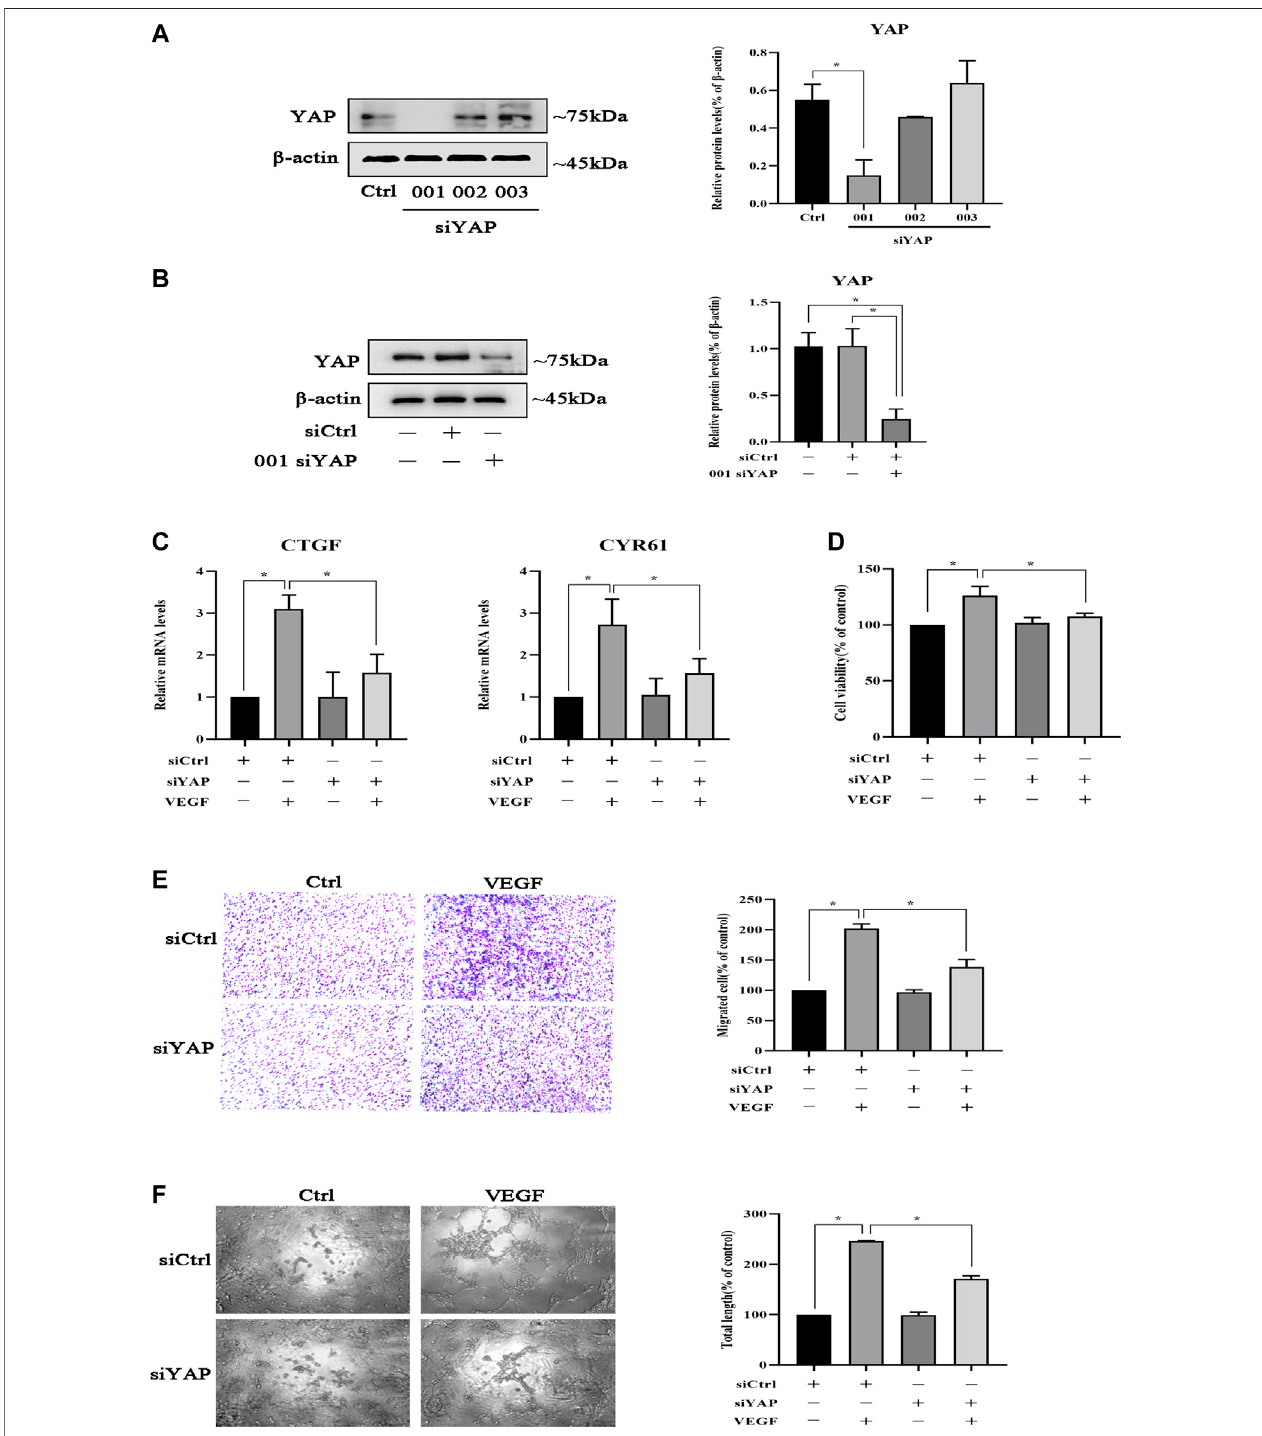
FIGURE5| YAPisinvolvedintheinhibitionofHPVECmigrationandtubeformation. (A) HPVECsweretransientlytransfectedwiththreekindsofSignalSilenceYAP siRNA for 48 h. Then YAP protein expressions were analyzed by western blotting. (B) HPVECs were transiently transfected with the SignalSilence YAP control siRNA (siCtrl) and 001 siRNA for 48 h. Western blotting was also used to detect YAP protein expression. (C – F) HPVECs were treated with siCtrl or YAP siRNA for 48 h and incubated with VEGF (50 ng/ml). (C) CTGF and CYR61 mRNA levels were analyzed by real-time PCR. (D) Cell proliferation was detected by CCK-8 assay. (E) MigrationofHPVECswasdetected bytranswellmigrationassay. (F) Tubeformationwasquanti fi edbycountingthetotal lengthinthree randomlyselected fi eldsofview. Data represent mean ± SEM of at least 3 independent experiments (* p < 0.05).